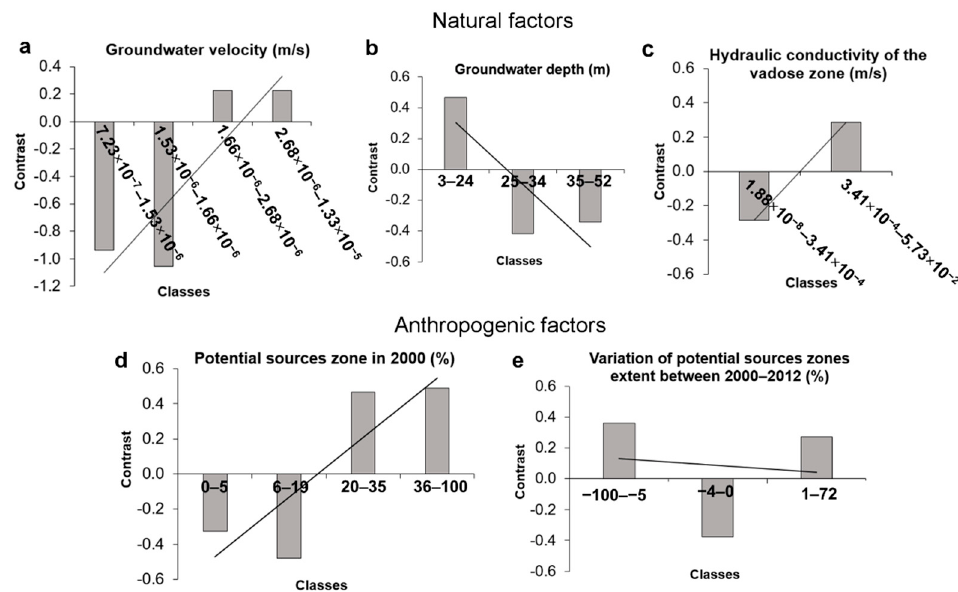
Figure 6. Contrasts of the statistically significant classes of each evidential theme: ( a ) groundwater depth; ( b ) groundwater velocity; ( c ) hydraulic conductivity of the vadose zone; ( d ) PSZ extent in 2000; ( e ) variation of PSZ extent between 2000 and 2012.